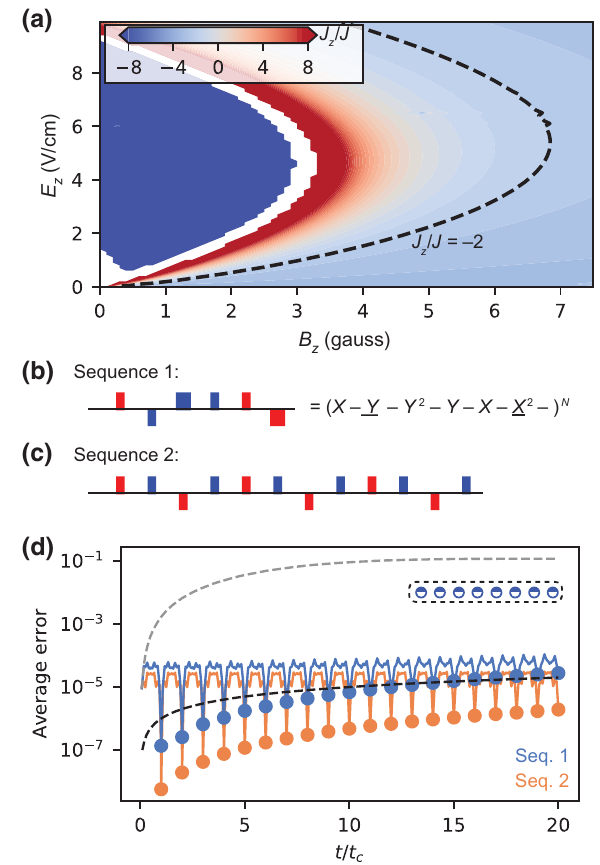
/ J ss as FIG. 6. Decoupling storage-state interactions. (a) J ss z a function of electric and magnetic fields. The dashed line = − 2 J ss . (b) Sequence 1: 6- shows the dipolar condition J ss z pulse WAHUHA-like sequence that cancels dipolar interactions and disorder. Red (blue) pulses denote ± π/ 2 rotations around the ˆ x ( ˆ y ) axis, with the minus sign for pulses indicated by bars below the line. The longer pulses are π rotations. In the text rep- resentation, X , Y are π/ 2 rotations (or − π/ 2 if underlined). (c) Sequence 2: 12-pulse sequence with better robustness to finite pulse duration, pulse-angle errors, and thermal motion (Sec. VII). (d) Storage error for an eight-atom chain without DD (gray dashed line), and with the sequences 1 (blue) and 2 (orange). For both, the sequence period is t c = 0.021 / J ss ≈ 3.7 μ s, and the pulse duty cycle is N p t p / t c = 2.5 × 10 − 2 . The enlarged data points show the fidelity at the refocusing times t = Nt c . The black dashed line shows the incoherent error resulting from a finite circular lifetime τ circ = 3 s, for